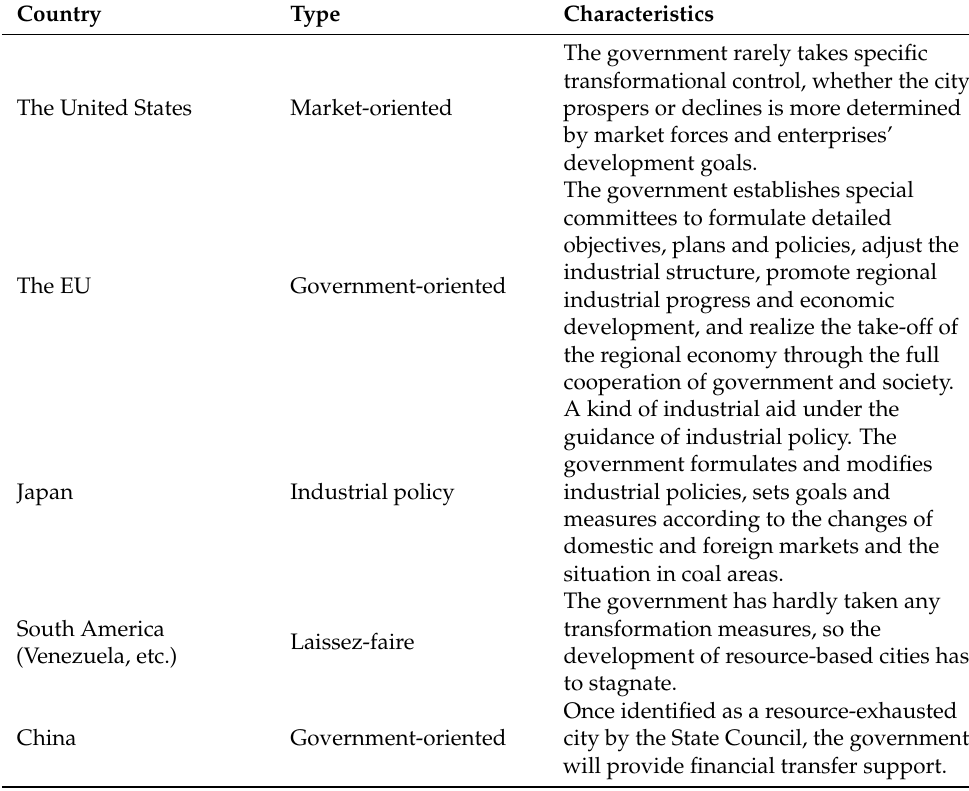
Table 2. Policy orientations of transformation cases of resource-exhausted